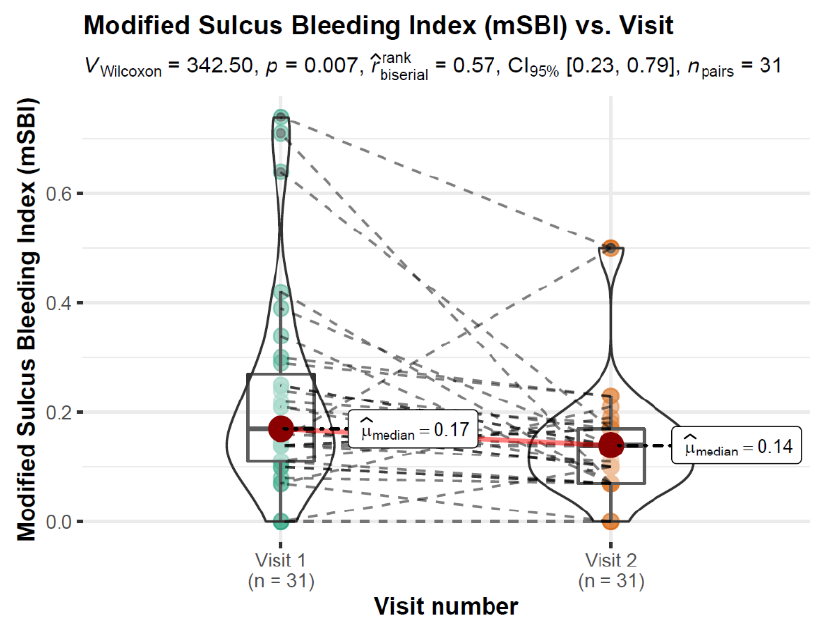
Figure 4. Modified Sulcus Bleeding Index vs. Visit variable with differences in means statistical reporting.